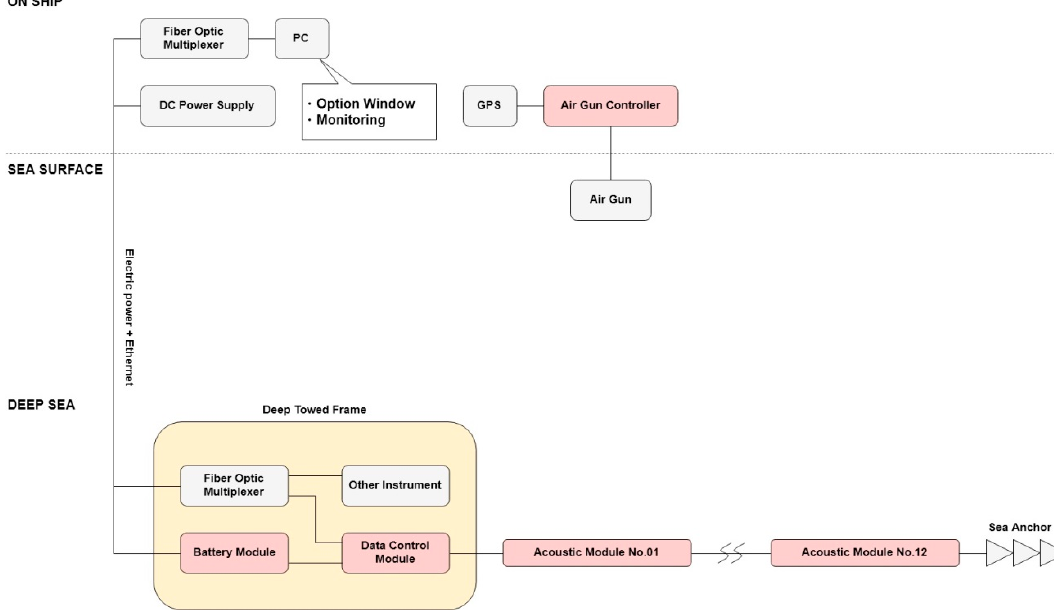
Figure 1. Block diagram of the deep-towed streamer.